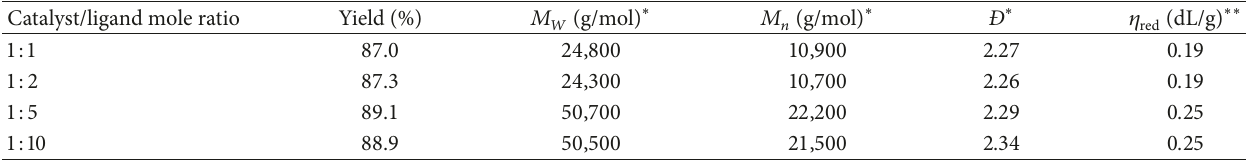
Table 8: The influence of the catalyst/ligand mole ratio on the characteristics of PE8E4. Catalyst/ligand mole ratio